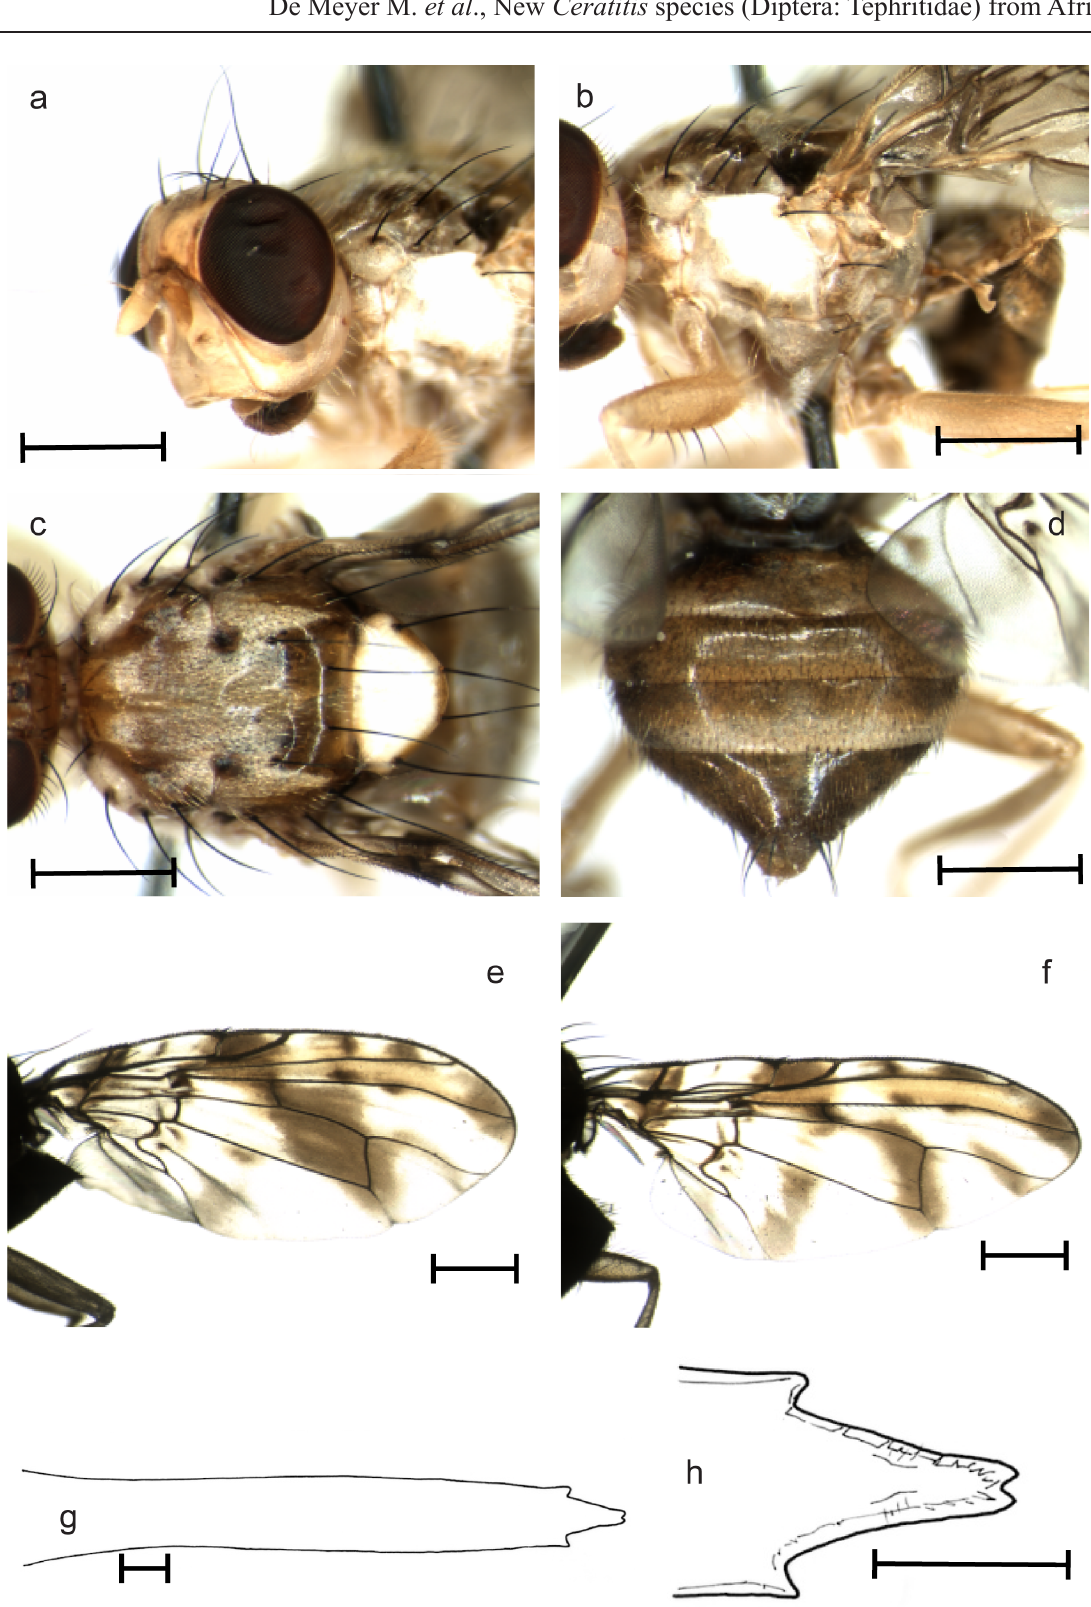
Fig. 3. Ceratitis taitaensis De Meyer & Copeland sp. nov. a . Head and thorax, anterodorsal view. b . thorax, lateral view. c . thorax, dorsal view. d . abdomen, dorsal view. e. Male wing. f . Female wing. g . Female aculeus. h . aculeus tip. Scale bars: a–F = 1 mm; g–H =